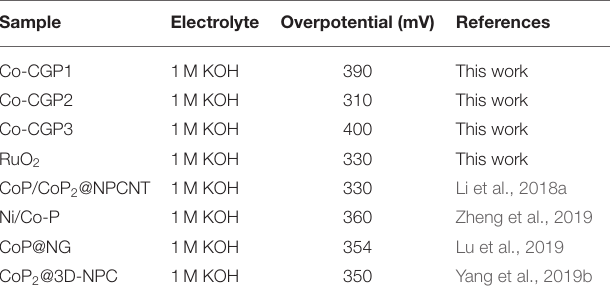
TABLE 2 | The OER activity comparison of recent Co-based catalysts.